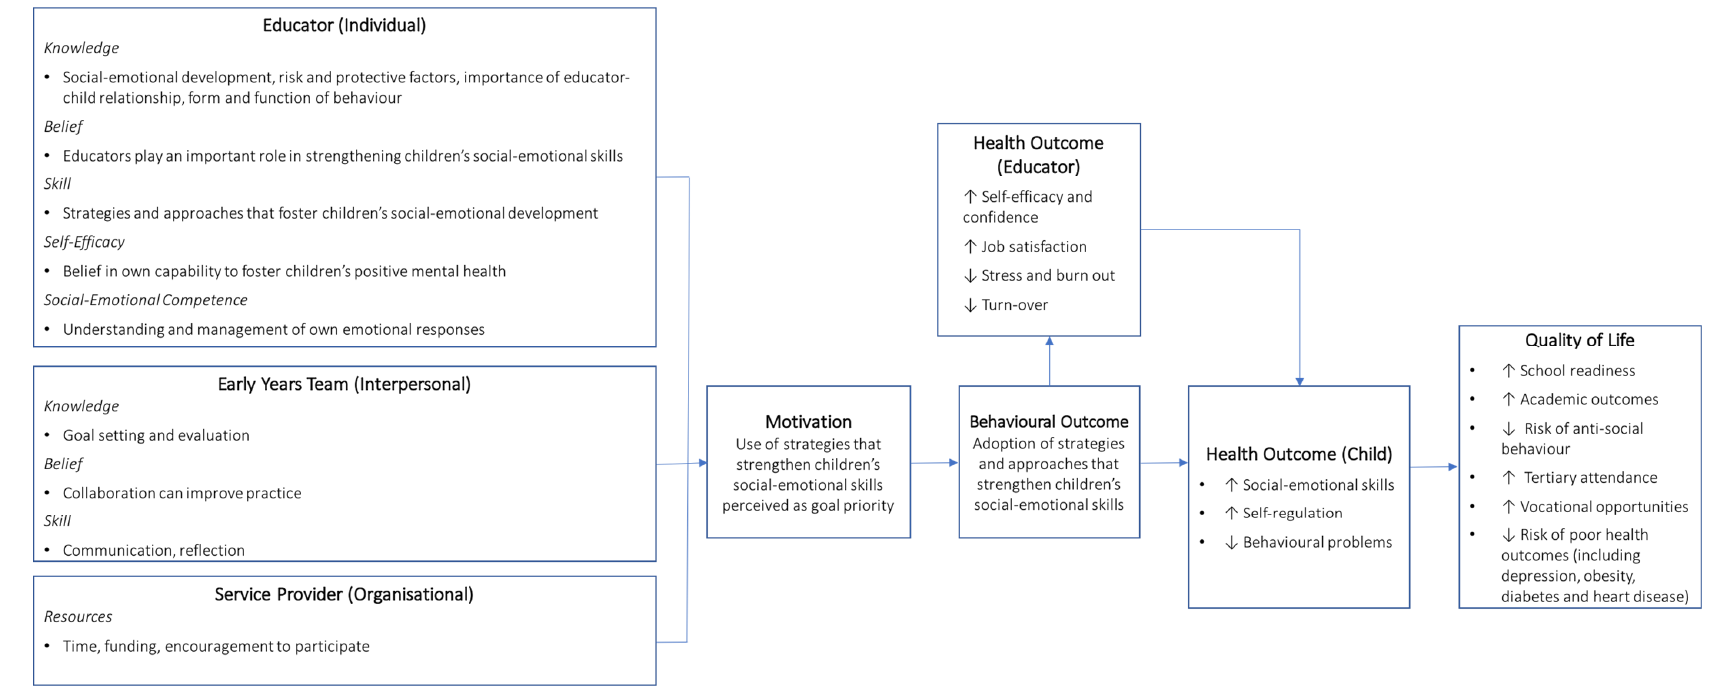
Figure 1. Logic model for Cheshire SEED Educational Program. SEED: Social-Emotional Engagement and Development.